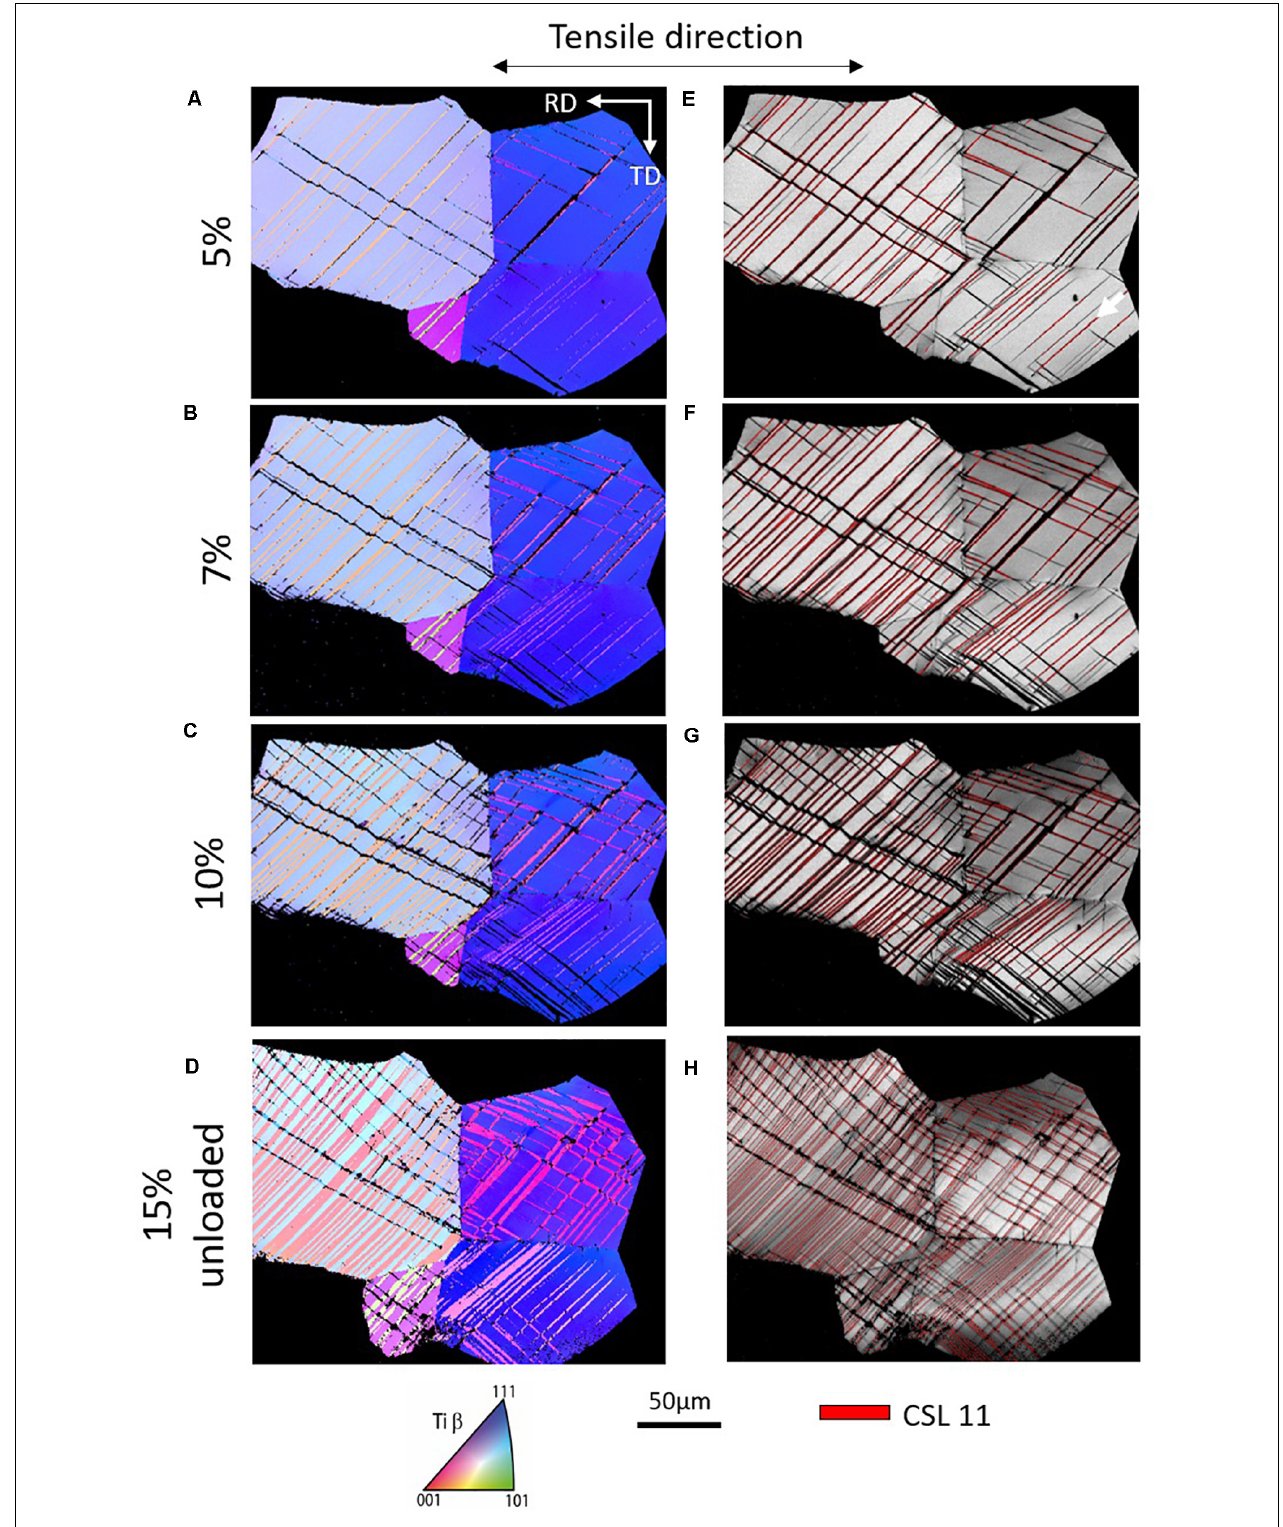
FIGURE 6 | In situ follow of the deformation in Ti–8.5Cr–1.5Sn. (A–D) Electron backscatter diffraction IPF images along the normal direction at 5, 7, 10, and 15% after unloaded (surface slightly electropolished) and (E–H) corresponding image qualities. Bands in red correspond to a 50.5 ◦ < 110 > misorientation (CSL (cid:54) 11) equivalent to {332} < 113 >